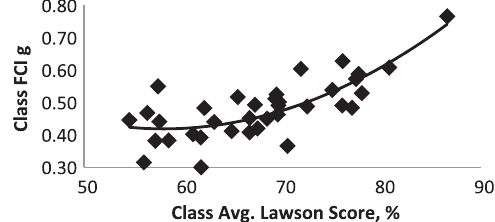
FIG. 3. Class average data for 36 classes at ASA, with a total of 803 students ( r ¼ 0 . 78 ). Here we have used a quadratic fit to the data, providing a better fit to the data than a linear function ( r ¼ 0 . 78 vs r ¼ 0 . 71 ).